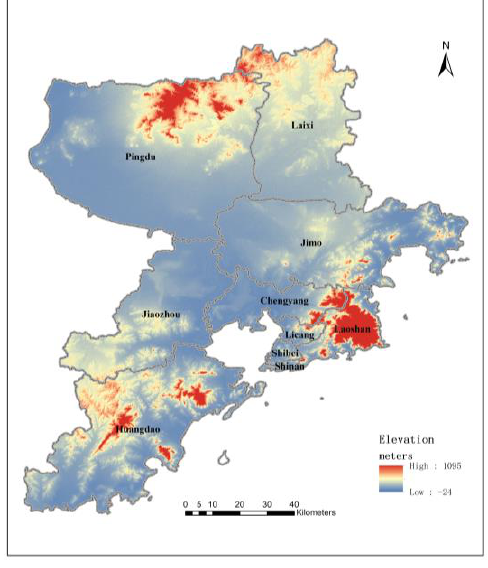
Figure 1 . The topography of Qingdao